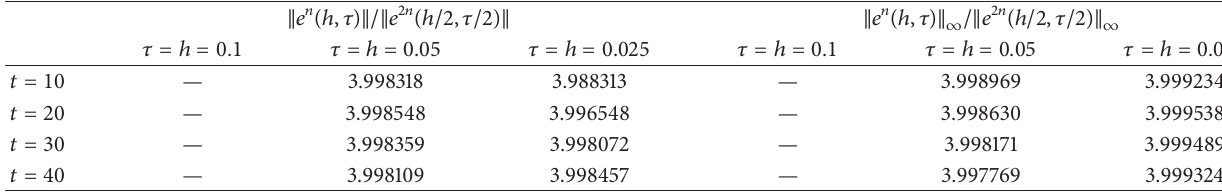
Table 3: The verification of the second convergence of Scheme I.